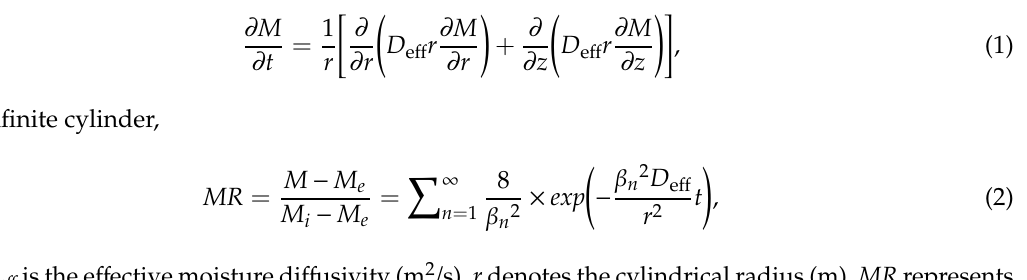
e ff ect of heating rate on the rheological properties of surimi paste, various heating rates (1–30